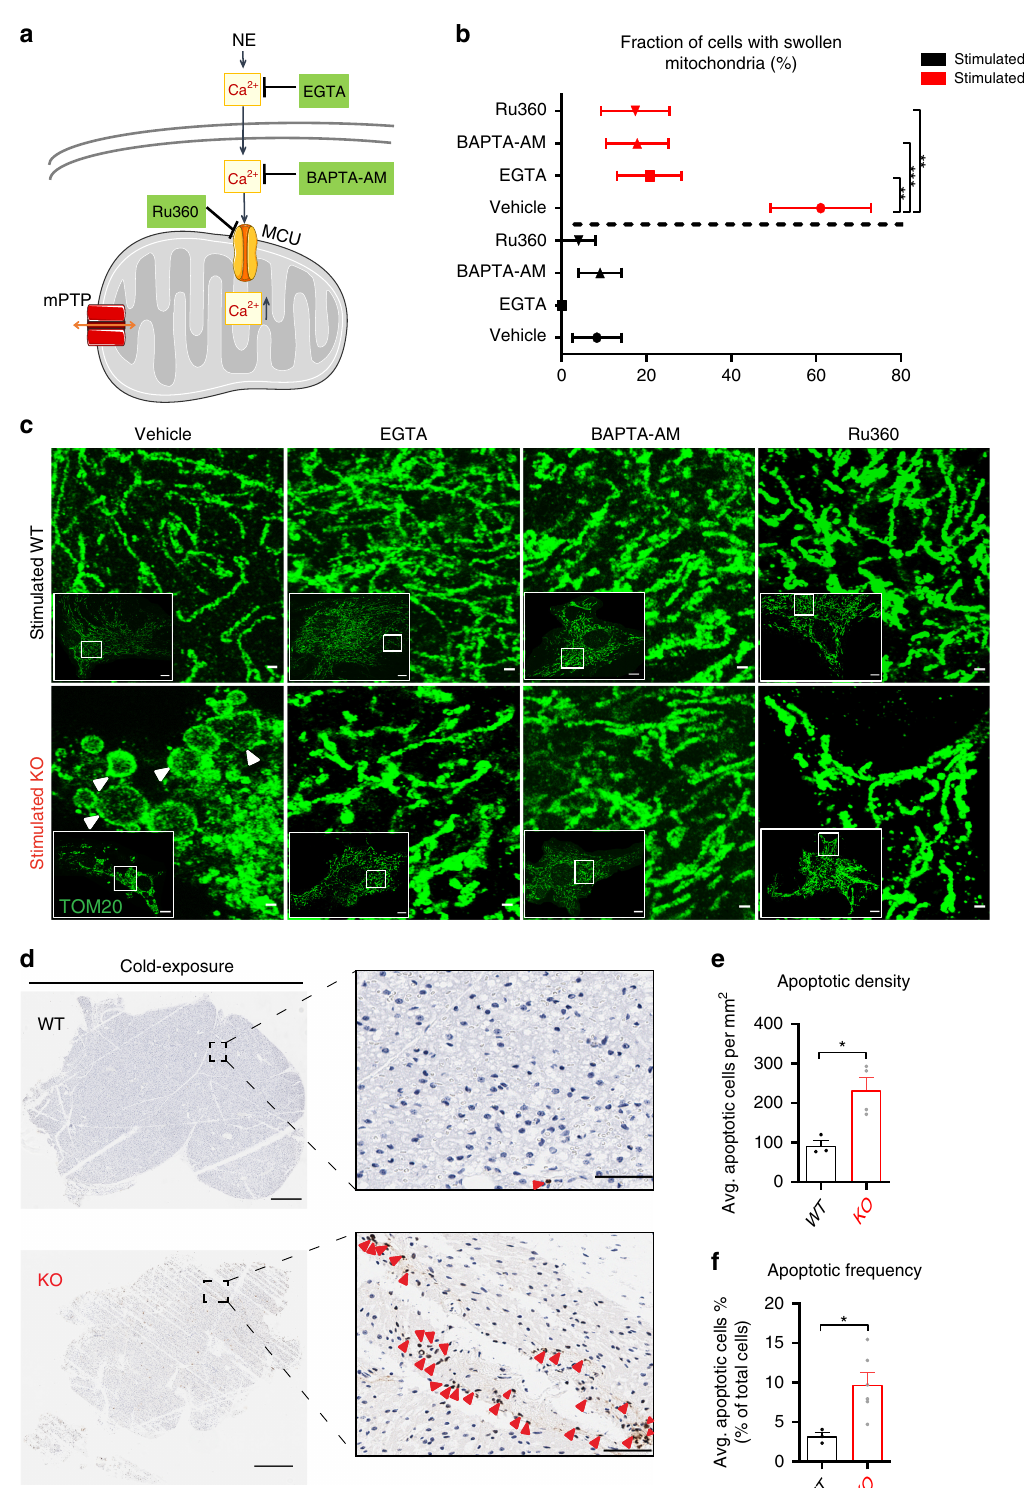
Cell culture . Primary BA were generated by differentiating preadipocytes isolated from BAT as described in detail previously 48 – 50 . BAT was harvested from 3 to 4- week-old WT and NCLX KO mice. The tissue was dissected from interscapular, subscapular, and cervical regions, minced, and transferred to a collagenase diges- tion buffer (2mg/ml Collagenase Type II in 100 mM HEPES, 120mM NaCl, 4.8 mM KCl, 1mM CaCl 2 , 4.5 mM glucose, 1.5% BSA, pH 7.4) at 37 ° C water incubator under constant agitation for 30min with vortex every 5min. Digested tissue was homogenized and strained through 100 and 40 μ m strainers.